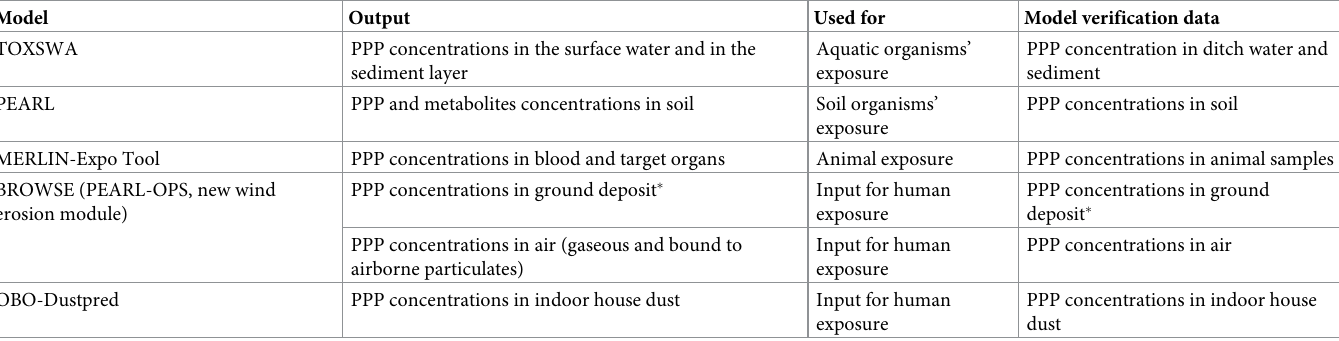
Table 2. Overview of fate and exposure models to be used in CSS, including their output type and use.